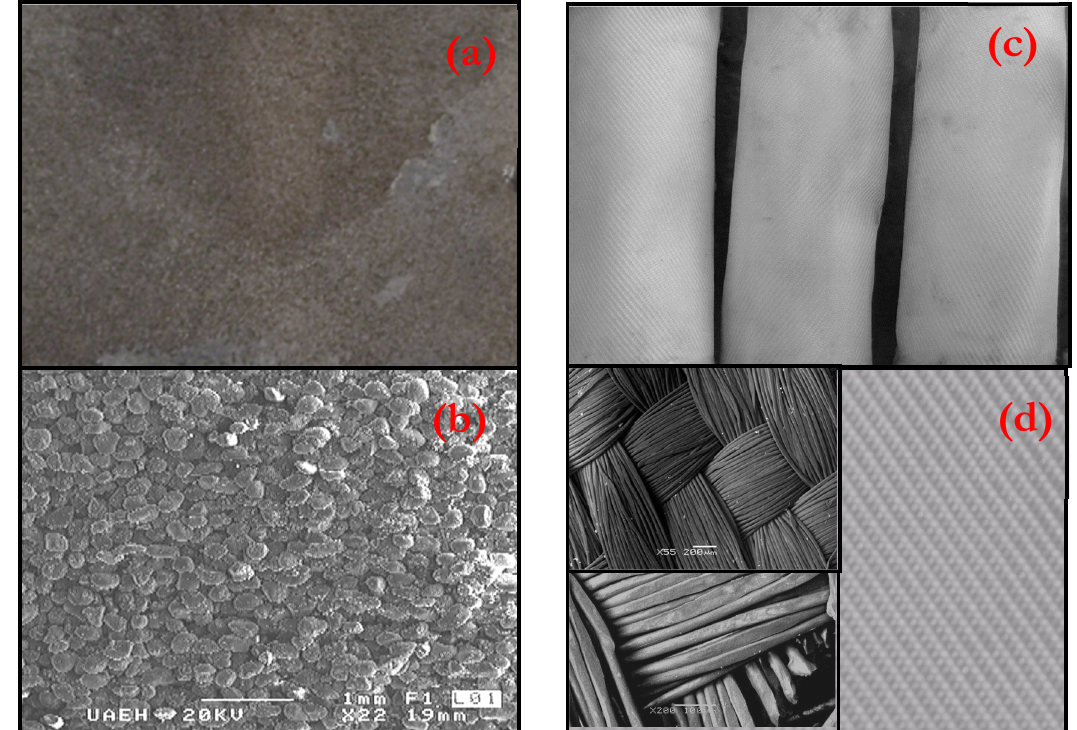
Figure 2. ( a ) Appearance of the flat sparger, and ( b ) micrography of the surface porosity; ( c ) appearance of the battery of cylindrical spargers, and ( d ) texture of the superficial porosity of the synthetic fabric.